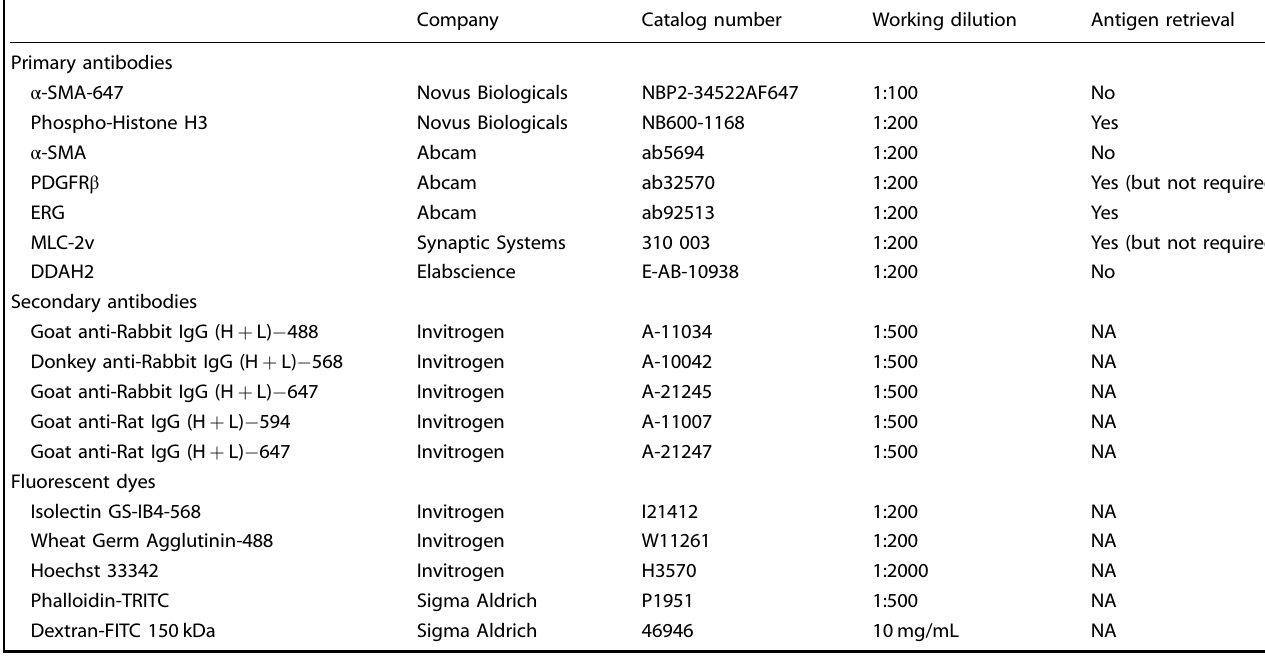
Table 1. Antibody and fl uorescent dye list.